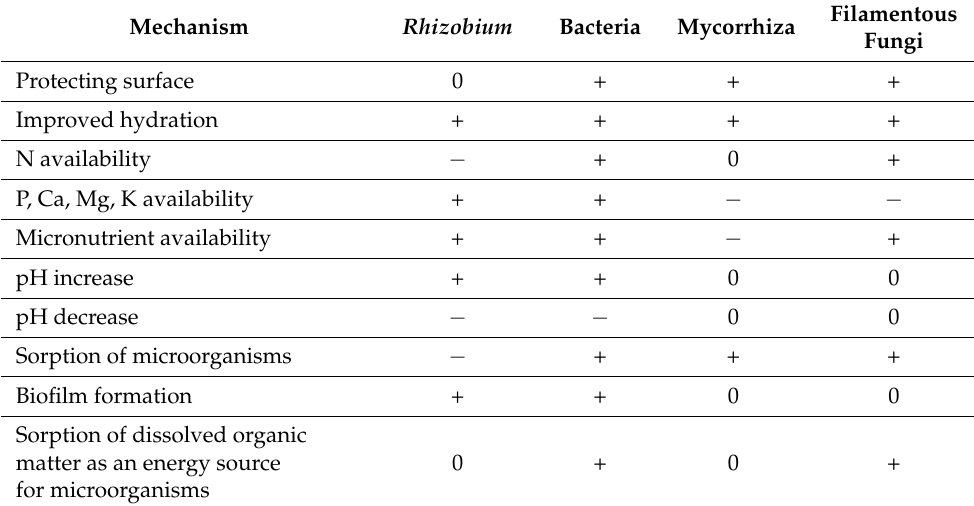
Filamentous Fungi